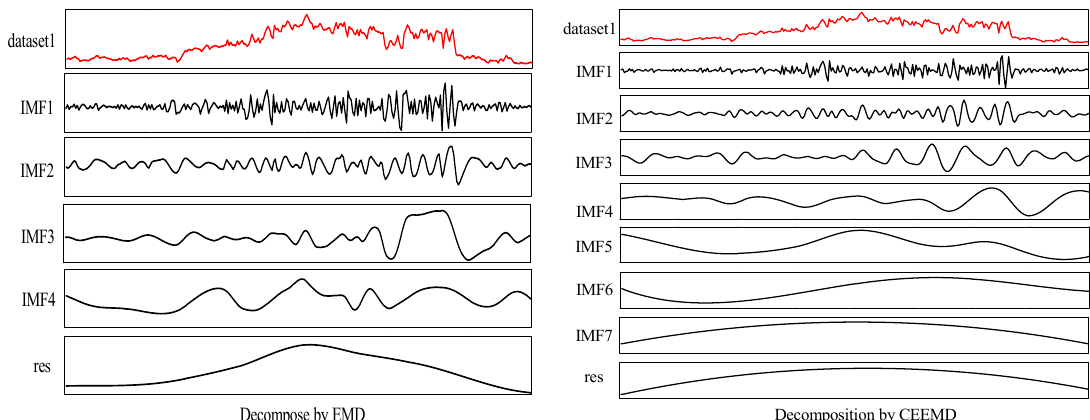
Figure 3. EMD and CEEMD decomposition diagram of dataset 1.